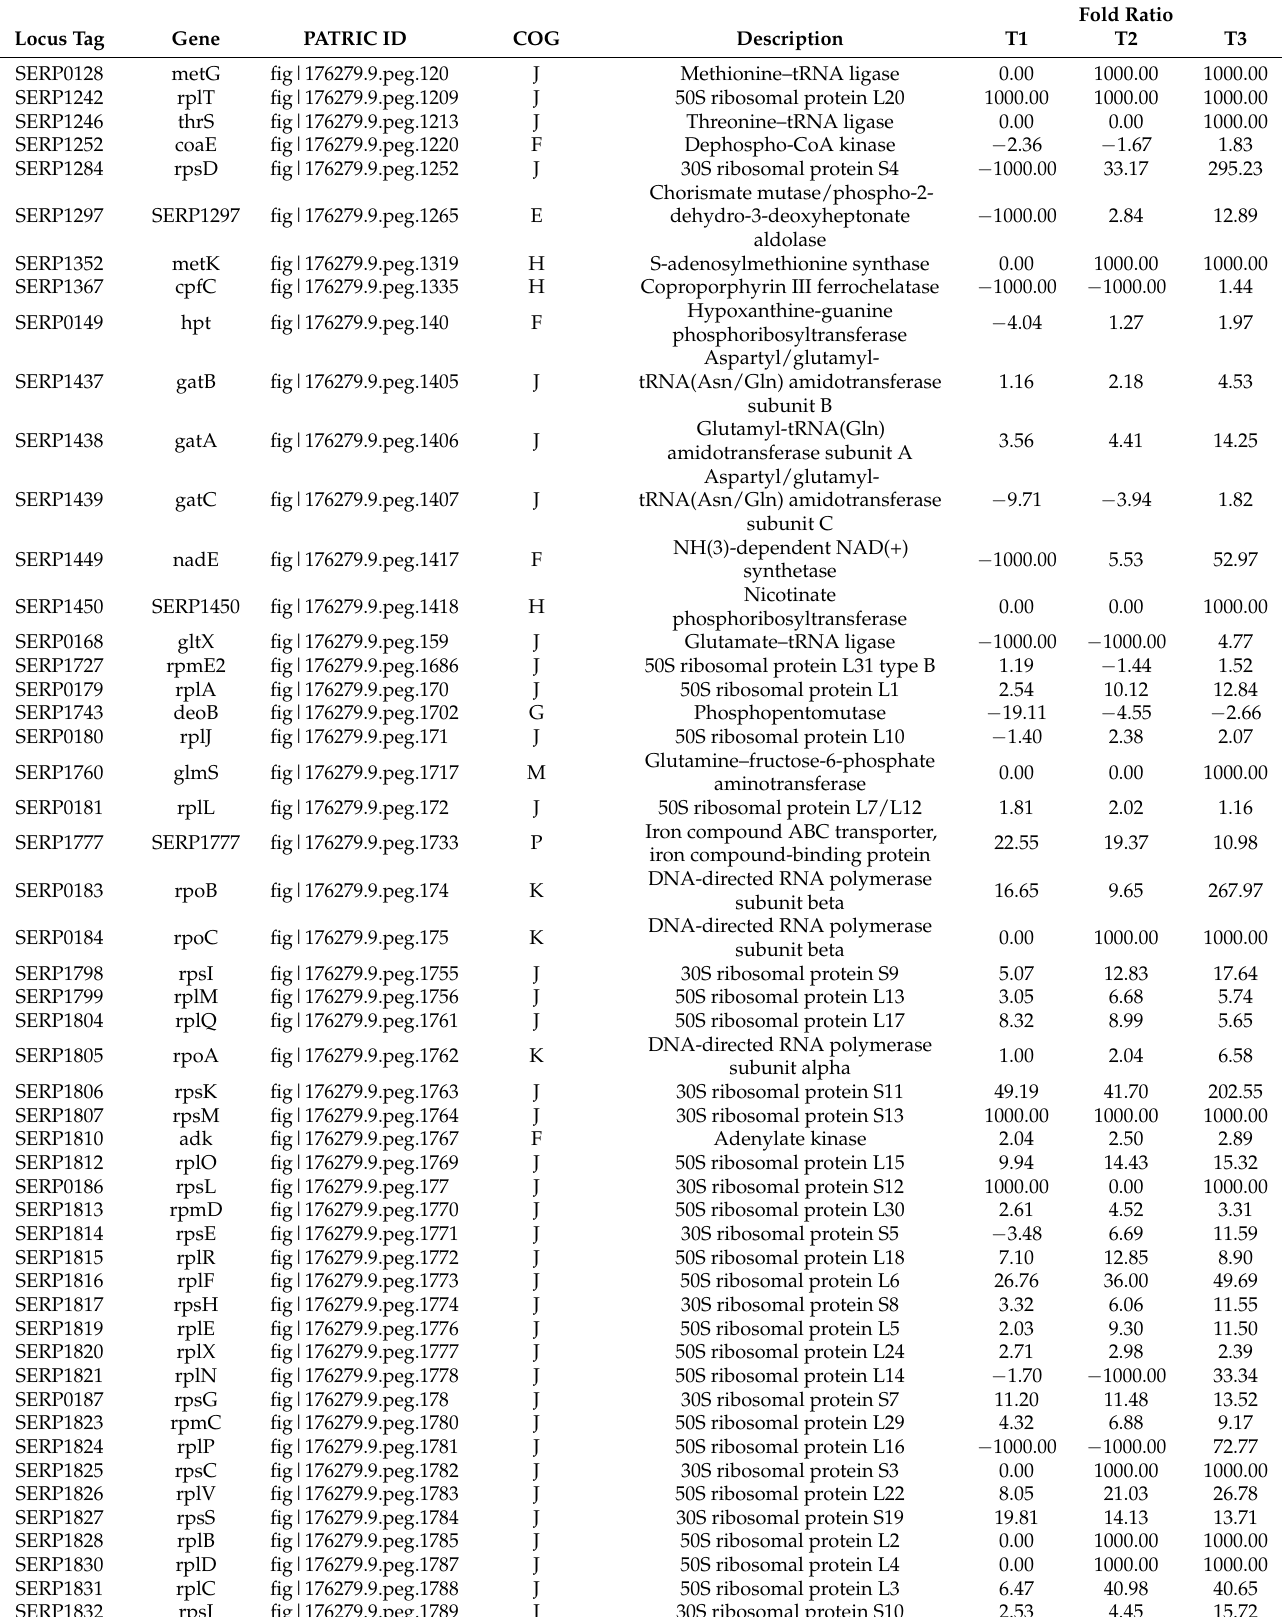
fig|176279.9.peg.1772 fig|176279.9.peg.1774 fig|176279.9.peg.1777 fig|176279.9.peg.1778